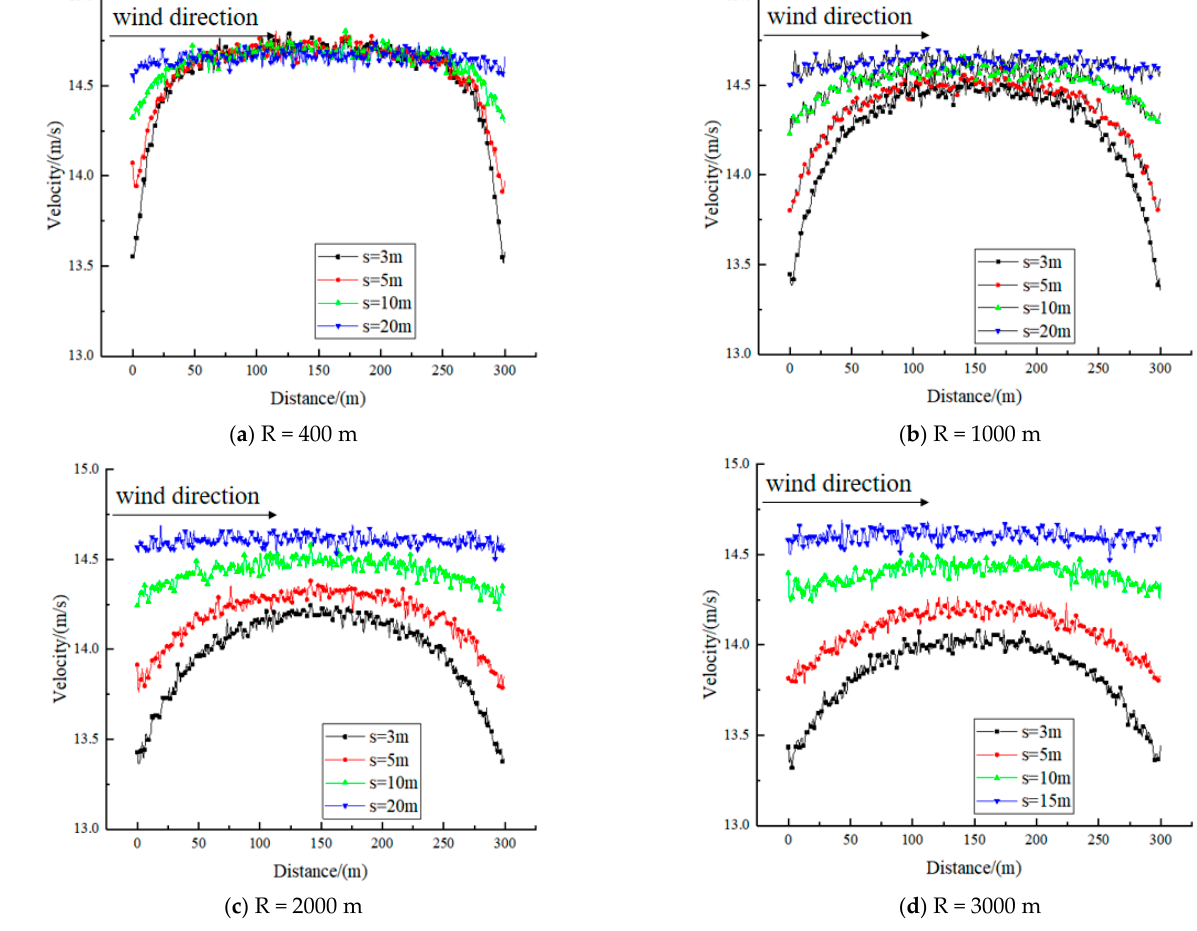
Figure 11. Wind-speed variation on the windward side of the concave curve at Z = 1.5